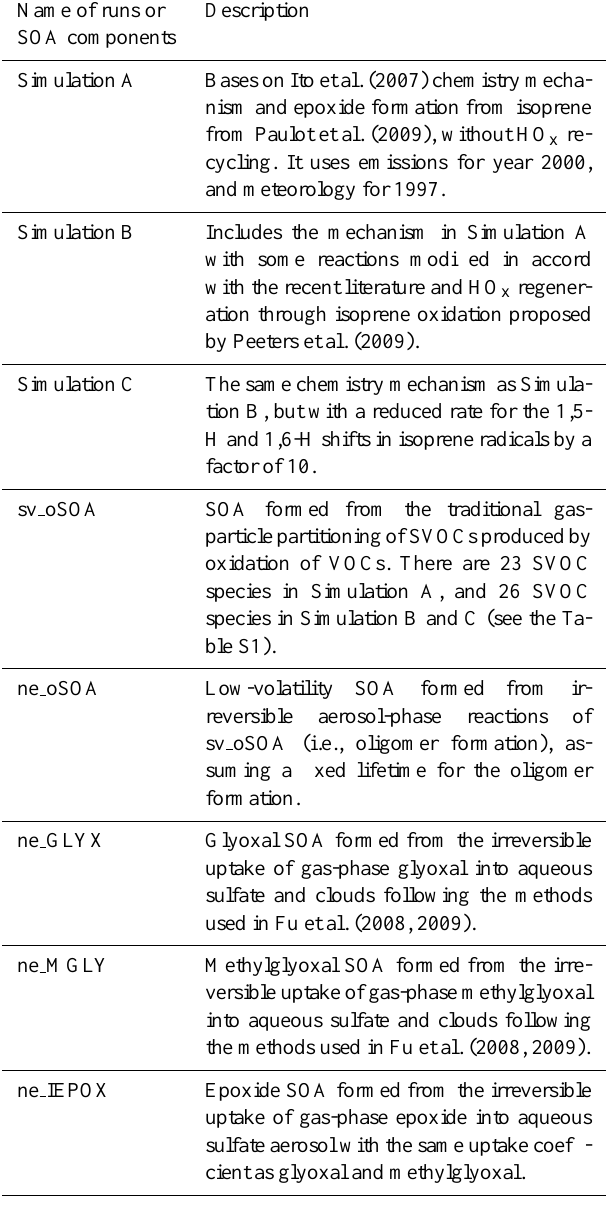
Table 1. Description of three runs and five SOA components per- formed in this